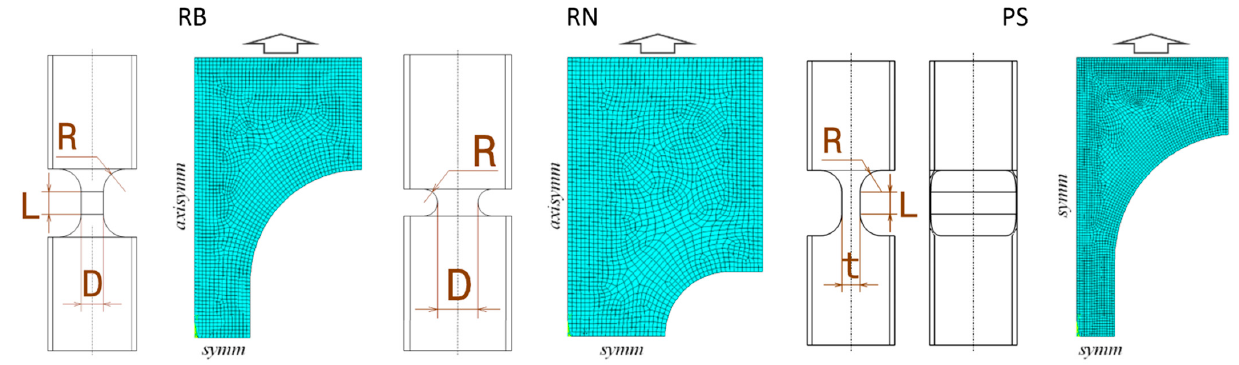
Figure 2. Shapes of test samples used in dynamic tests and FEM models used for their optimization.